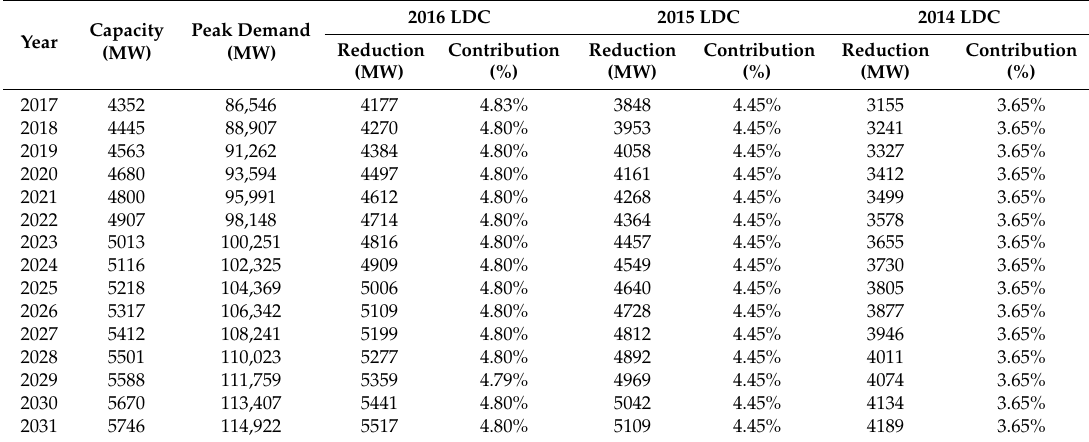
Table 4. Summary of reference case simulation results (2014–2016 LDC).